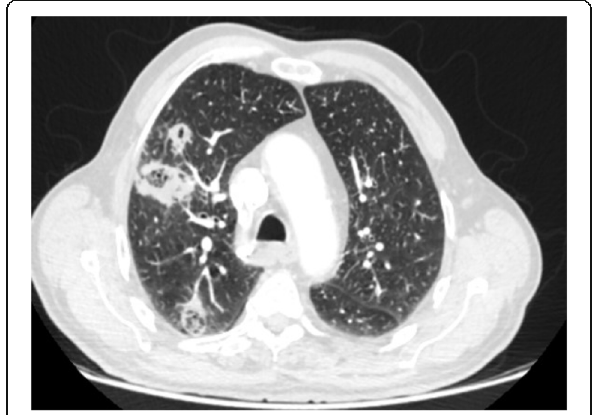
Fig. 10 Pulmonary zygomycosis: thin section CT shows multiple nodules with reversed halo sign (RHS) in the right upper and lower lobes